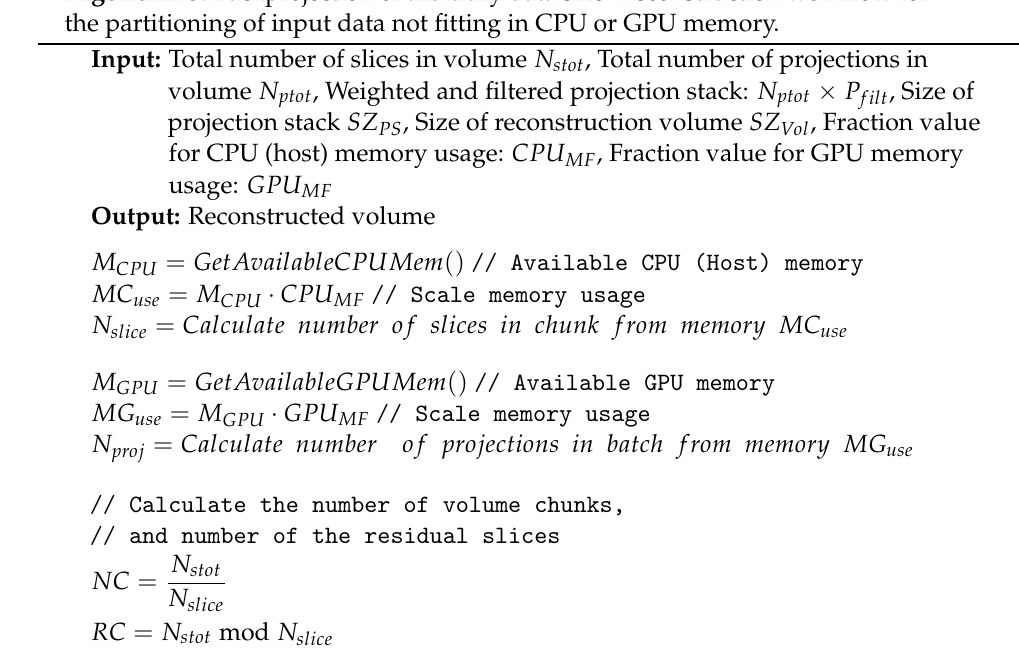
Algorithm 3: Backprojection of arbitrary data size. Reconstruction workflow for the partitioning of input data not fitting in CPU or GPU